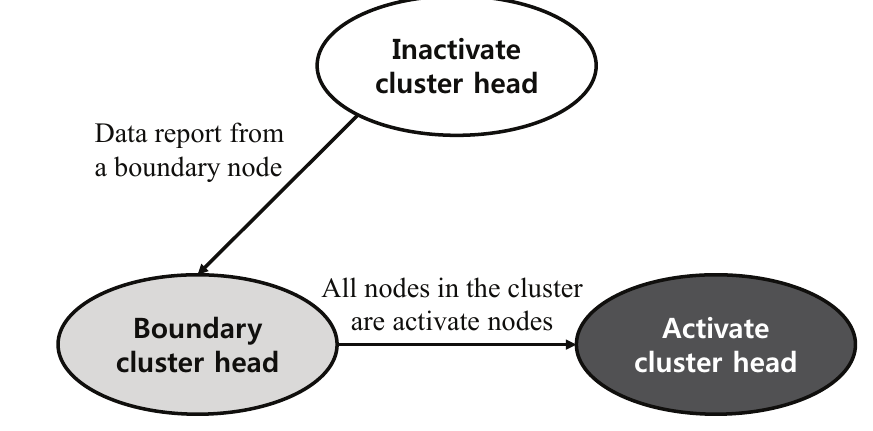
Figure 12. The state transition diagram of cluster